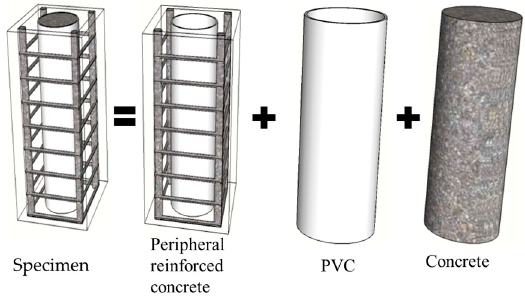
Figure 14. Force simplification model.